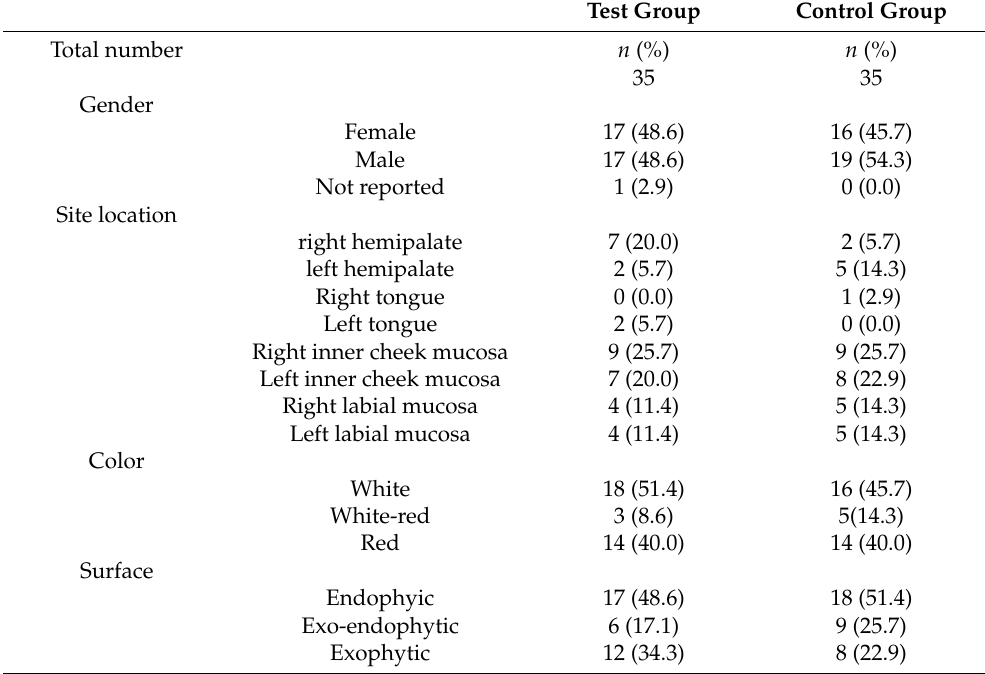
Table 1. Demographic variables and qualitative clinical variables at baseline (T0).